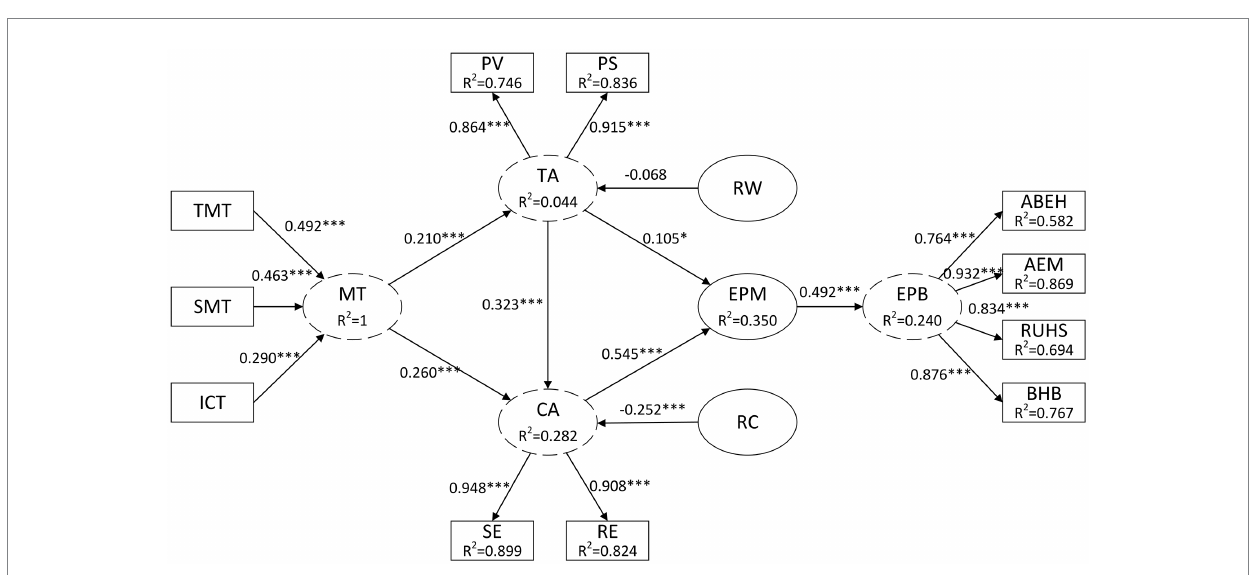
Second-order construct. TMT, Traditional Media Trust; SMT, Social Media Trust; ICT, Interpersonal Communication Trust; MT, Media Trust; TA, Threat Appraisal; CA, Coping Appraisal; PV, Perceived Vulnerability; PS, Perceived Severity; SE, Self-efficacy; RE, Response Efficacy; RW, Rewards; RC, Response Costs; EPM, Epidemic Prevention Motivation; EPB, Epidemic Prevention Behaviors; ABEH, Avoidance Behaviors of Environmental Hazards; AEM, Anti-epidemic Measures; RUHS, Rational Use of Health Services; BHB, Basic Health Behaviors. * p -value < 0.05; ** p -value < 0.01; *** p -value <